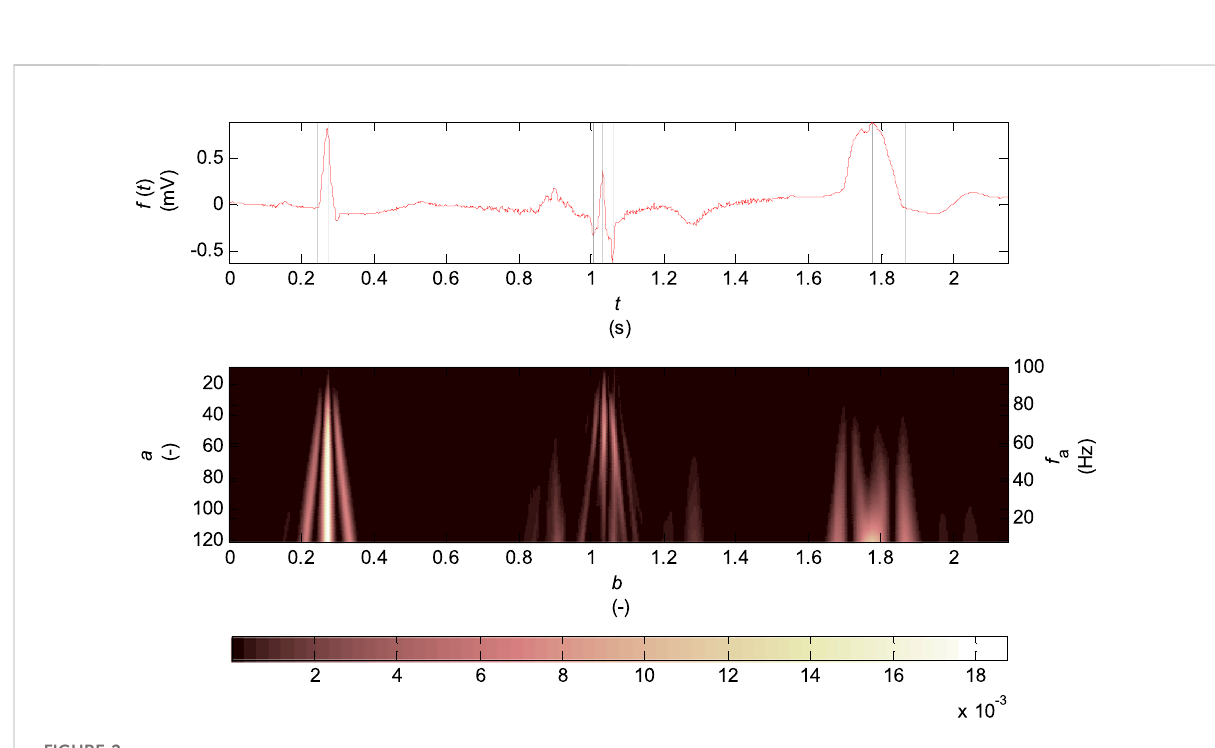
FIGURE 2 Scalogram of the continuous wavelet transform for biorthogonal wavelet 2.2, scale parameter a (cid:2) { 10 , ... , 120 } and corresponding pseudofrequencies f a (cid:4) { 100 , ... , 8 } Hz. The input signal is one lead VCG of one cardiac cycle of the named records of the diagnostic PTB database: from the left the “ s0130lre ” of a HC patient, the “ s0235lre ” of a MI patient, “ the s0448_re ” of a LBBB patient. The single Q, R, S waves are marked by dashed lines in the input signal.